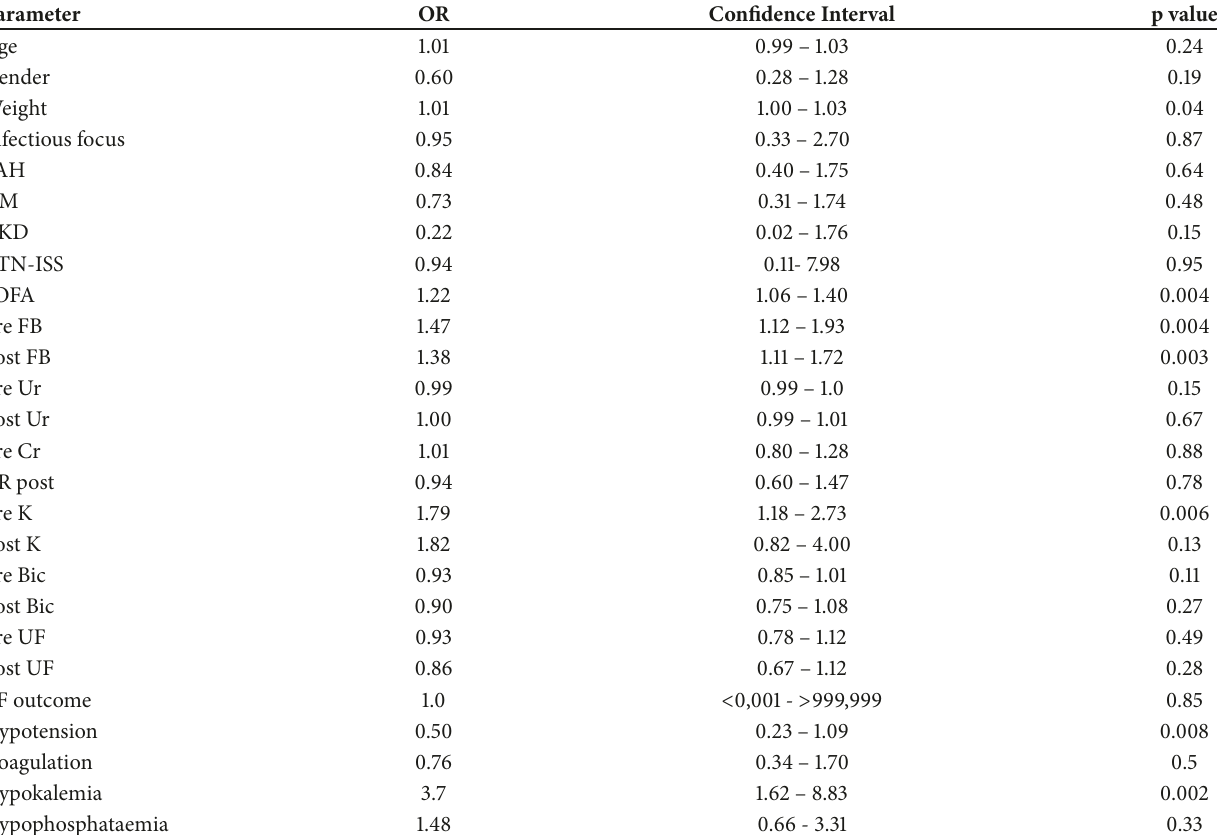
Table 5: Univariate logistic regression of clinical and laboratory characteristics, and dialysis complications associated with the death of patients with AKI treated with PHD.